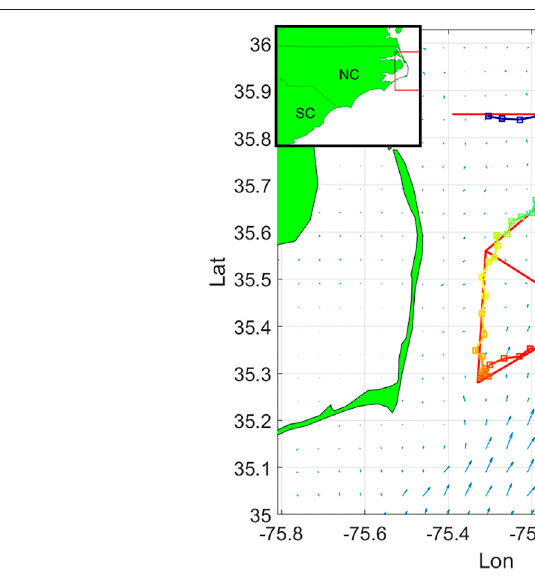
FIGURE 3 | Survey domain near Cape Hatteras. The curve represents glider trajectory during the fi rst PEACH deployment. The red line path is the pre-assigned sampling pattern. Squares denote the glider surfacing positions along trajectory, and color of the trajectory depicts timestamps. The arrows represent the NCOM- predicted fl ow fi eld at the starting time of the deployment.